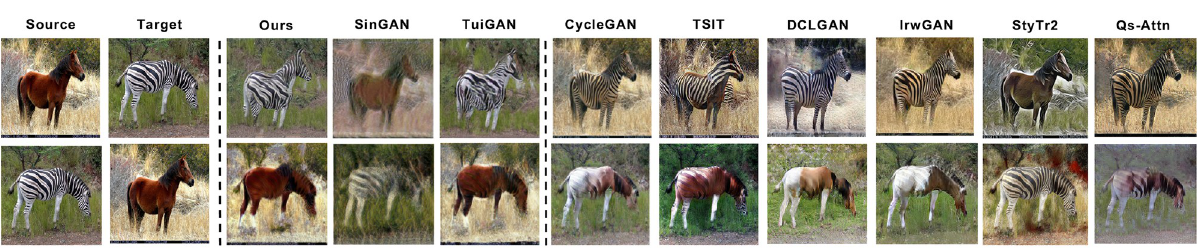
Fig 7. Translation results of CRPGAN with various baselines on Horse $ Zebra.